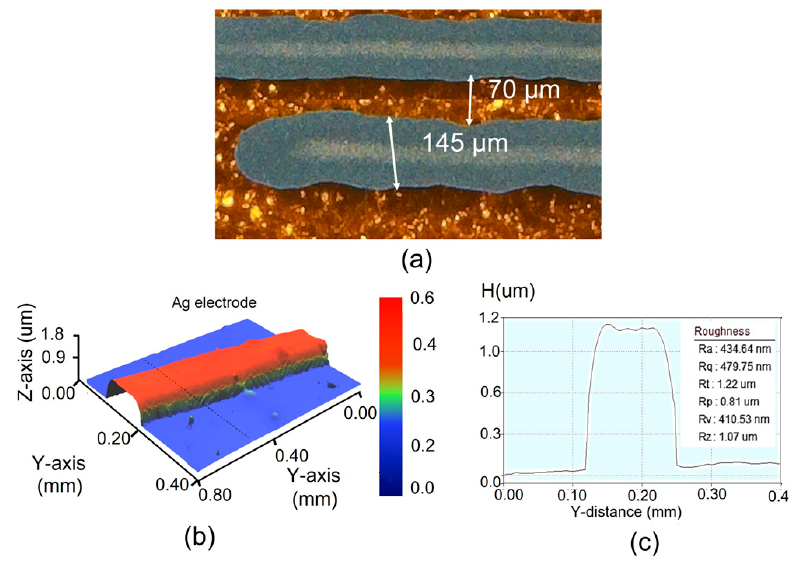
Figure 11. ( a ) Microscopic image of the Microheater Pattern Lines, ( b ) Ag Track Morphology Mea- surements using the Nano-Profiler, ( c ) Roughness Histogram of the Silver